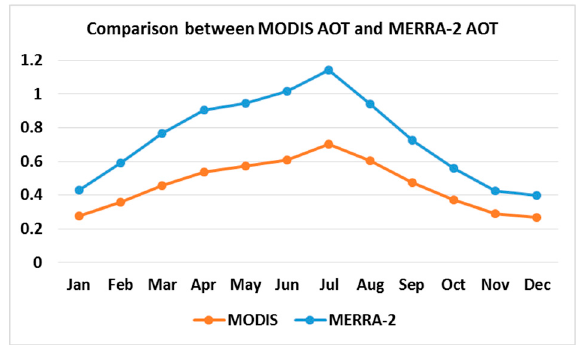
Figure 10. Comparison between MODIS AOT and MERRA-2 AOT.